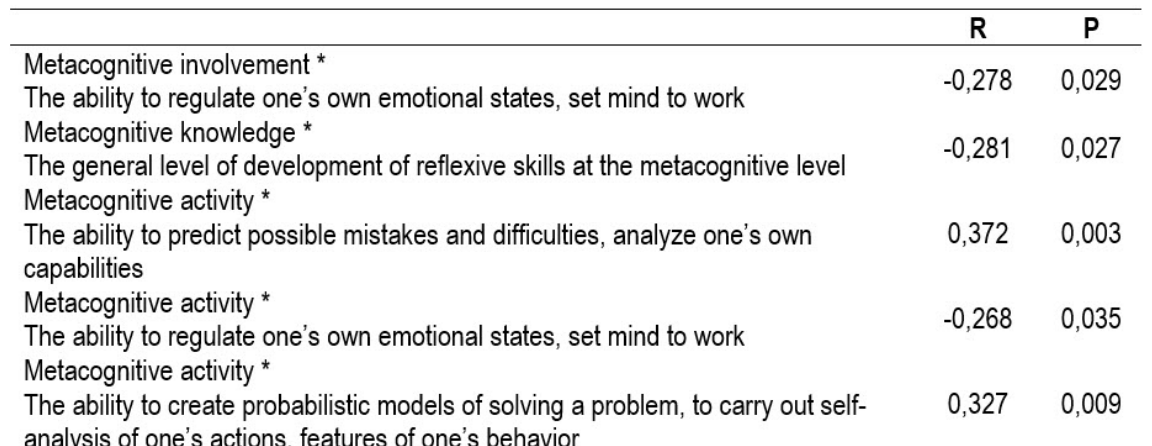
The results of the correlation analysis with the use of Spearmen’s correlation coefficient on the connection between metacognitive characteristics and reflexive skills at the metacognitive